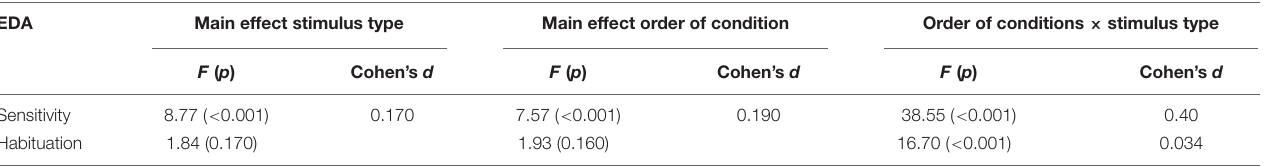
TABLE 1 | Condition and presentation effects, and interactions of sensitivity and habituation.